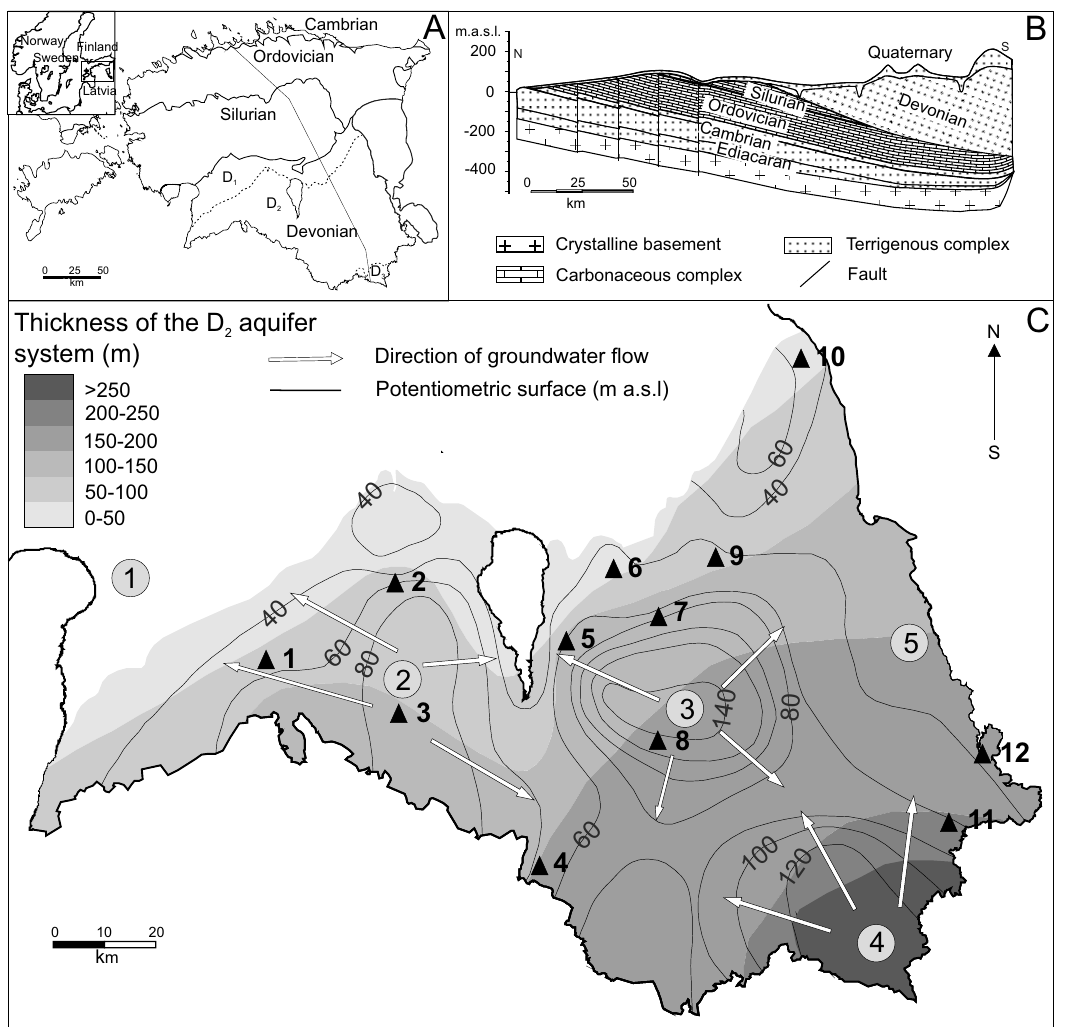
Fig. 1. A , schematic geological map; B , geological cross section of Estonia (N–S); C , the distribution, thickness and potentiometric surface of the Middle Devonian (D 2 ) aquifer system in South Estonia (after Raukas & Teedumäe 1997; Marandi 2010) and sampling sites (▲). Rock samples were collected from the following boreholes and outcrops: 1, Tõlla 1; 2, Viljandi; 3, Karksi; 4, Valga; 5, Valguta 263; 6, Karijärve 304; 7, Elva 262; 8, Otepää 2; 9, Mõra; 10, Pala 75; 11, Piusa; 12, Värska 1. Relief forms in the study area: 1, Pärnu Lowland; 2, Sakala Heights; 3, Otepää Heights; 4, Haanja Heights; 5, Peipsi